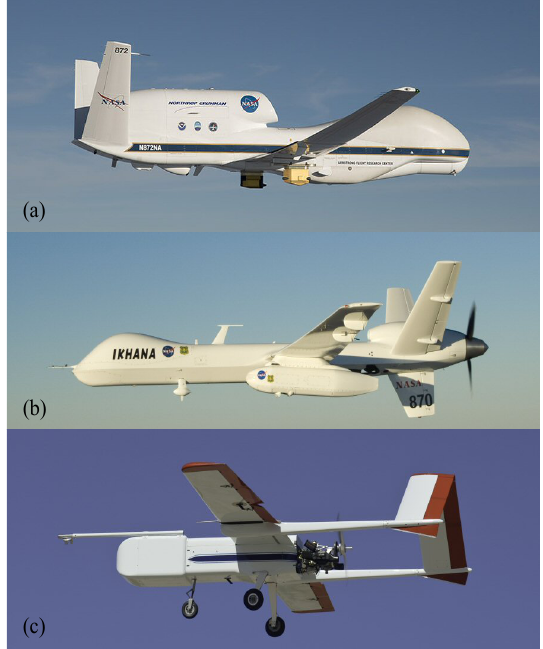
Figure 1. NASA UAS flown in support of Earth observations for science and applications at global (a, Global Hawk) regional (b, Ikhana) and local (c, SIERRA)